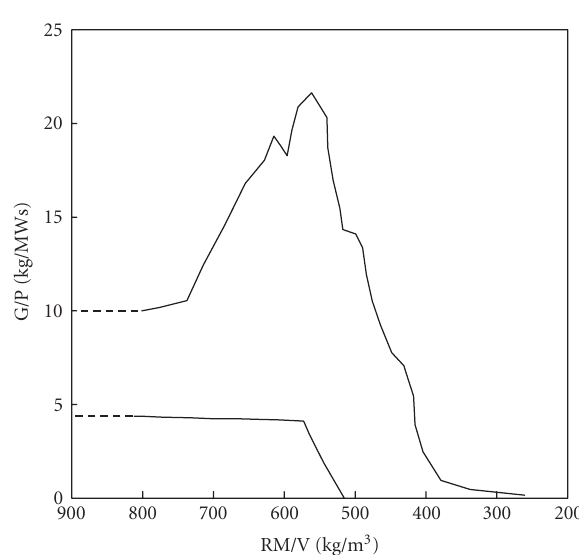
Figure 3: Natural circulation flow map achieved from the envelope of measured curves in PWR